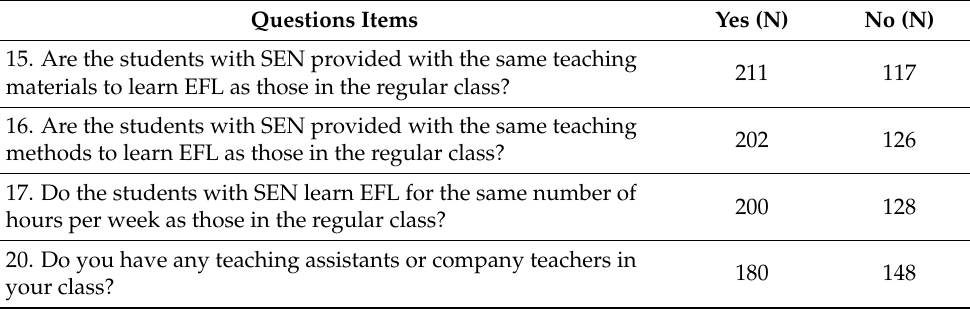
Table 3. Support services provided for students with SEN in the regular EFL class.